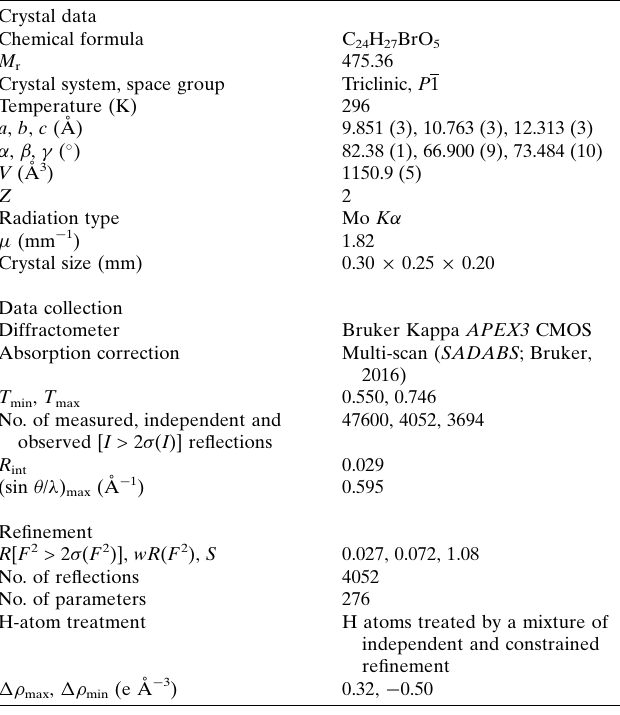
Crystal data Chemical